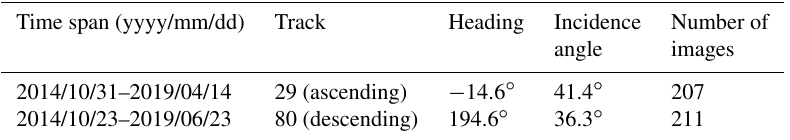
Table 2. Summary of Sentinel-1 data used in this study.